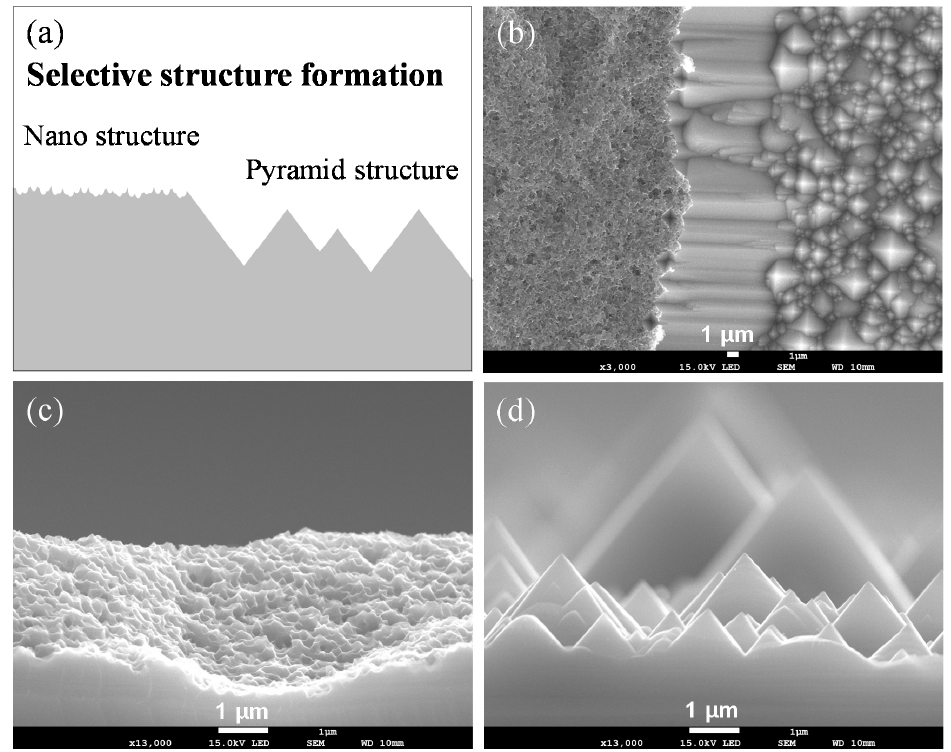
Figure 7. SEM image of the novel SE surface using a nanostructure and a micro-pyramid structure, ( a ) schematic diagram of the novel SE structure, ( b ) top view of the novel SE surface in 3 K